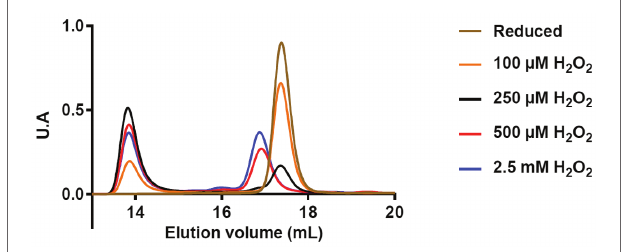
FIGURE 5 | Protein redox state of PIN1At affects its oligomerization and hydrodynamic features. Analysis of reduced PIN1At treated or not with the indicated concentrations of H 2 O 2 was performed by loading 300 μ g of protein on Superdex200 10/300 column coupled to a MALS detector and a differential refractometer.